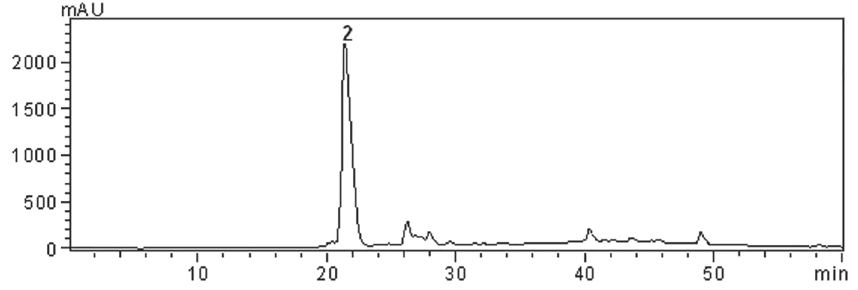
Figure 1 - HPLC analysis of chlorogenic acid (2) of the CRF fraction of the branches.